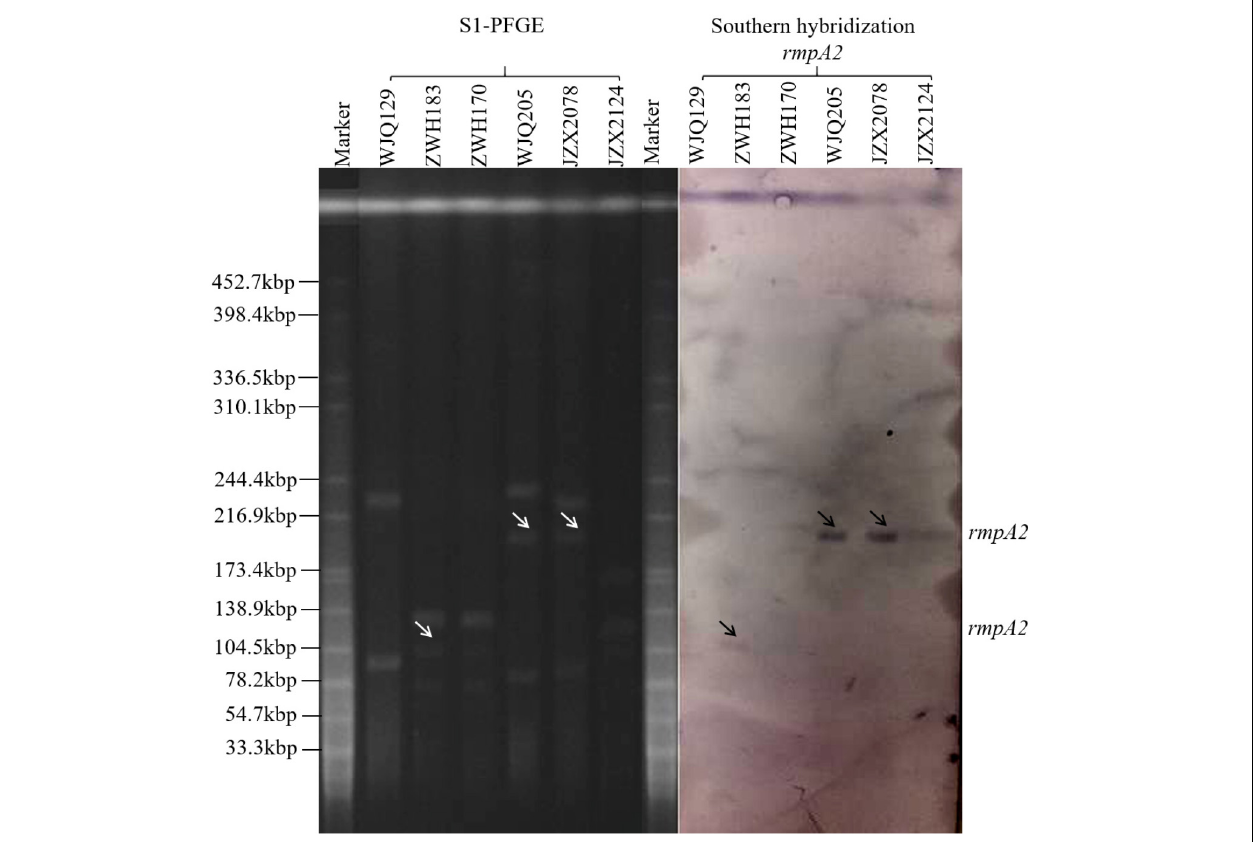
FIGURE 4 | Results of S1-PFGE and Southern hybridization of marker gene of the virulence plasmid rmpA2 harbored by KPC-2-producing CRKP isolates recovered from stool samples of three patients.